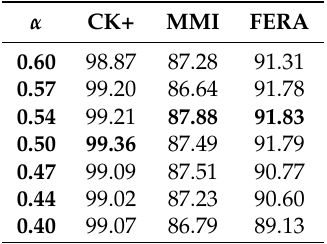
Table 4. Comparison of the average accuracy according to α